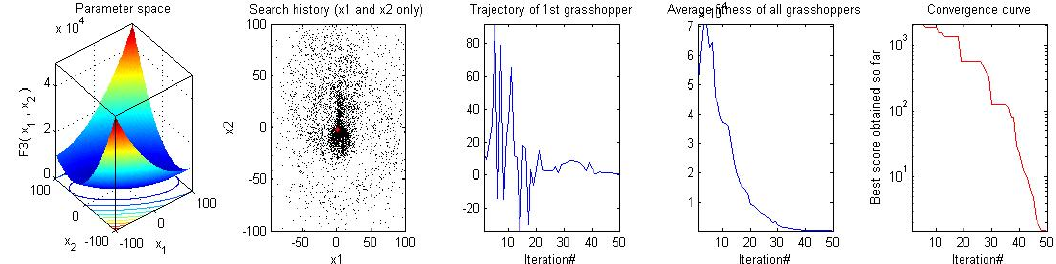
Figure 4. HAGOA search behavior on unimodal function (F3)